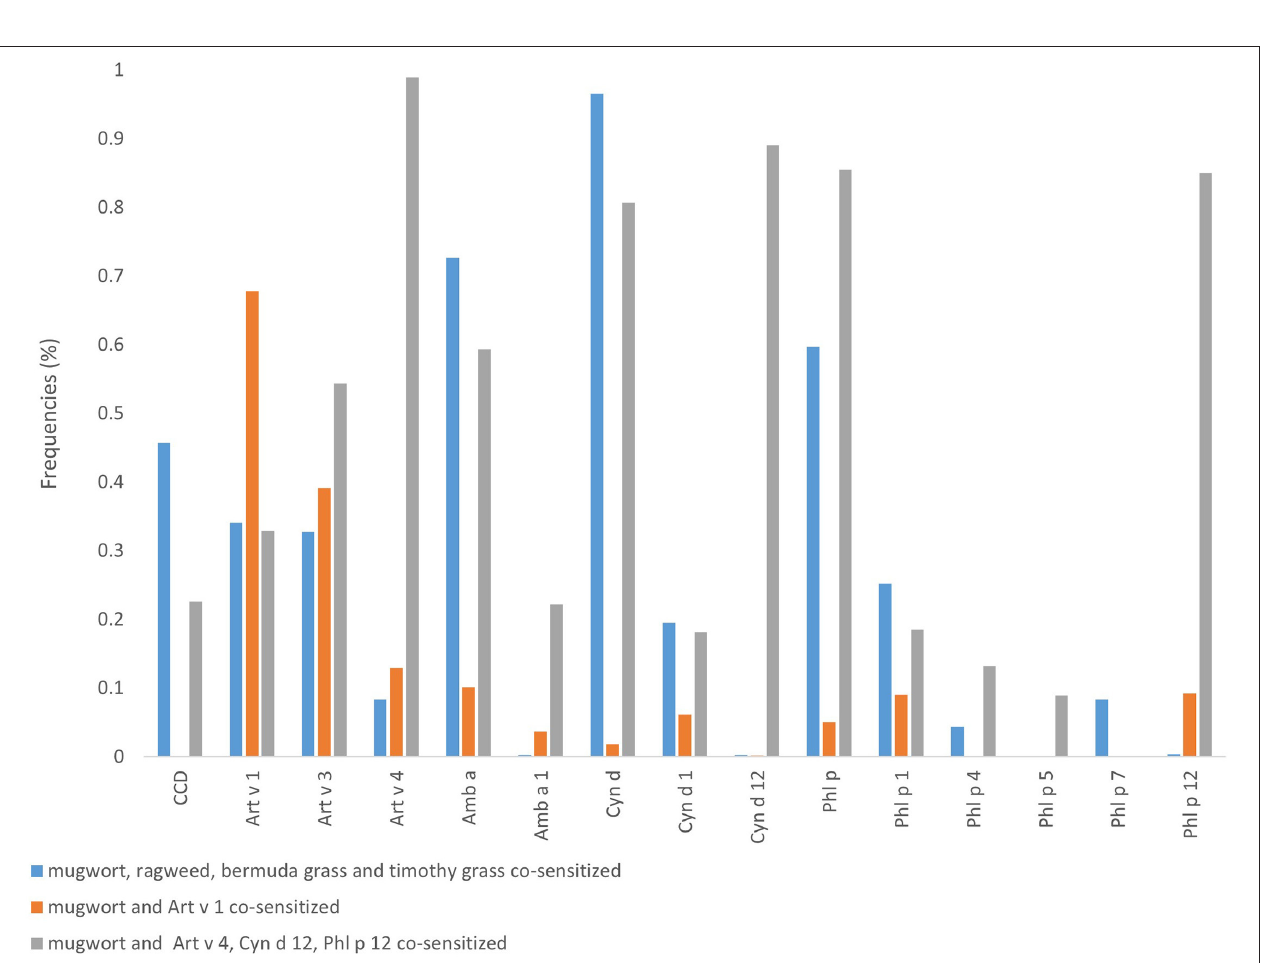
FIGURE 2 | Spearman correlation analysis among various grass pollen allergens and CCD. The numbers in the figure are Spearman’s correlation coefficient.